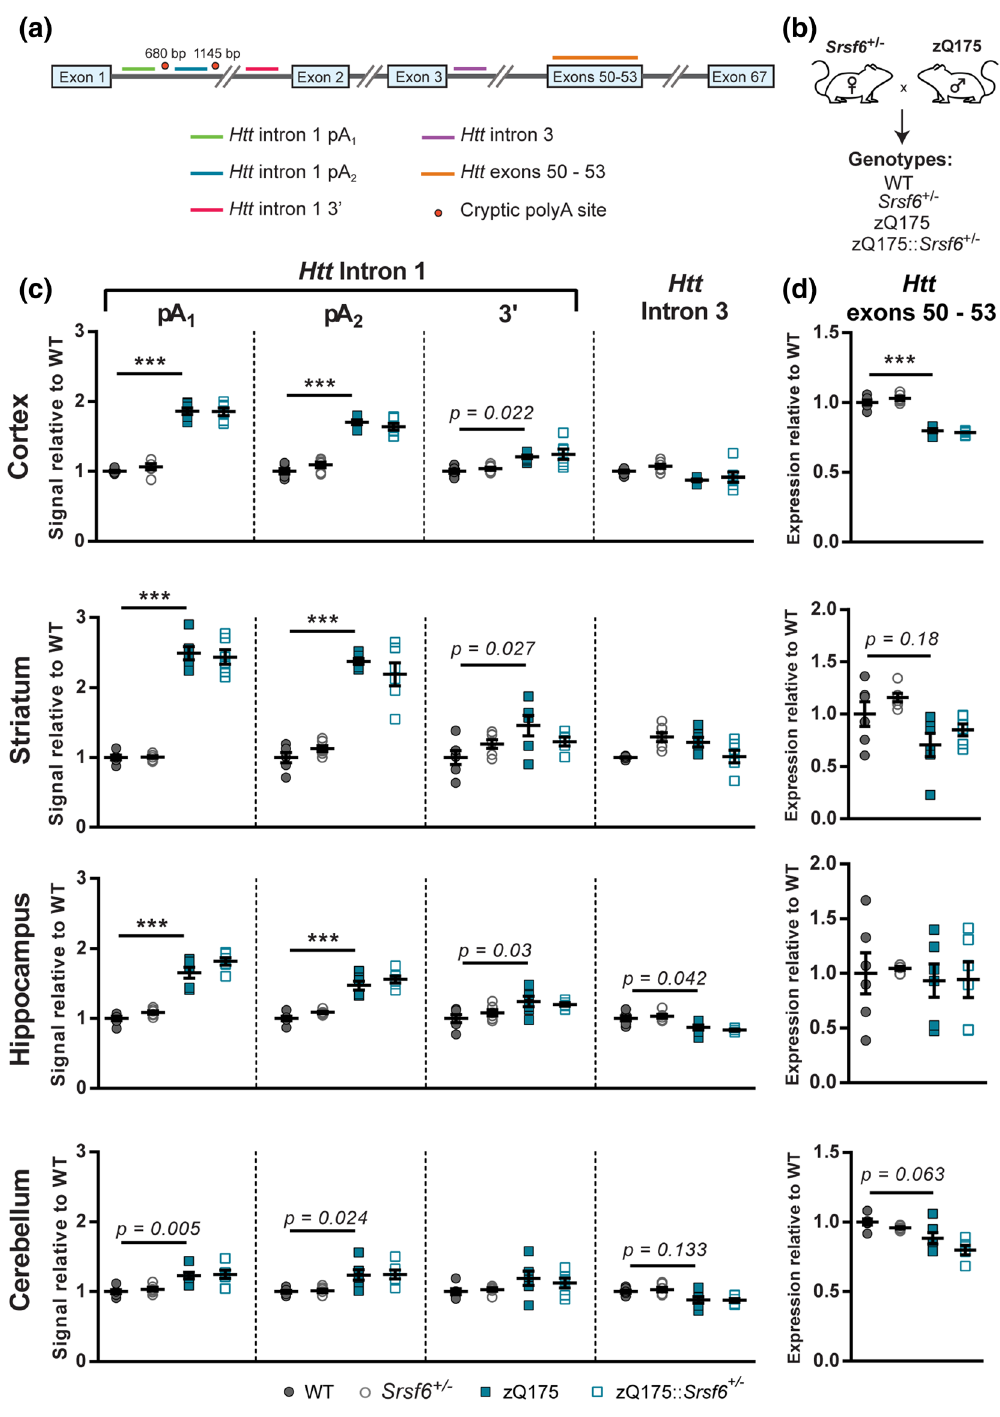
Figure 2. QuantiGene analysis of Htt transcripts in brain regions from the progeny of the zQ175 and Srsf6 + /− mouse cross. ( a ) Schematic of the location of the QuantiGene plex probe sets on the mouse Htt transcript. ( b ) Srsf6 + /− female mice were bred to zQ175 knockin male mice to generate progeny with four genotypes: WT, Srsf6 heterozygous knockout ( Srsf6 + /− ), zQ175 knockin and double mutants (zQ175:: Srsf6 + /− ). ( c ) Httexon1 was detected in the cortex, striatum, hippocampus and cerebellum of 2 month old zQ175 mice but was not altered by heterozygosity for Srsf6 knockout. ( d ) Full-length Htt was measured in the cortex, striatum, hippocampus and cerebellum using the Htt exon 50–53 assay. Cortical full-length Htt was significantly lower in zQ175 mice compared to WT and this was not changed by heterozygosity for Srsf6 knockout. n = 6/genotype. Statistical analysis was by one-way ANOVA with Bonferroni correction for multiple pairwise comparisons, *** p < 0.001, p < 0.2 values are indicated. Test statistics can be found in Supplementary Table S5. WT wild